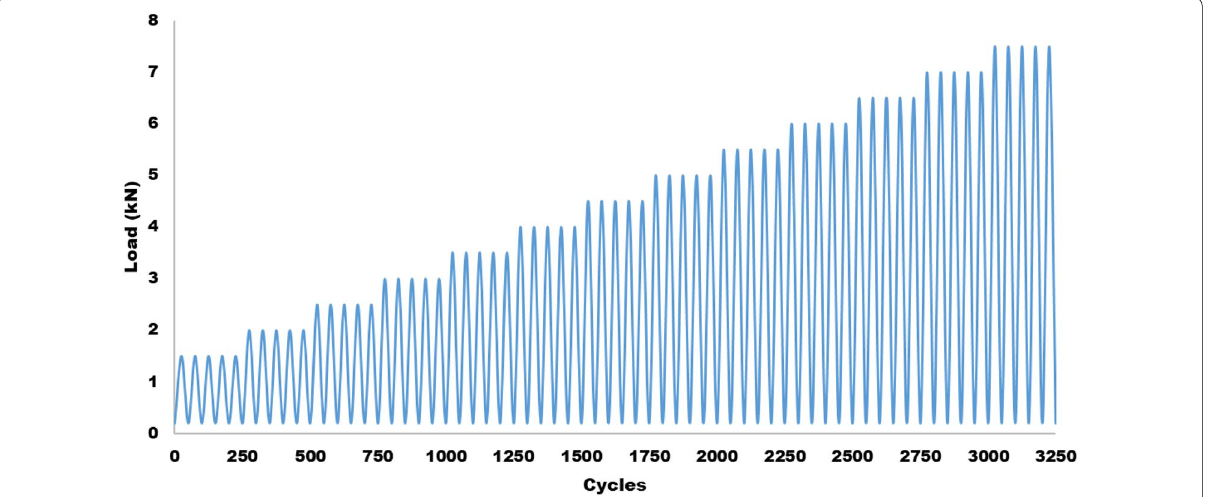
Fig. 4 Graphical representation of the loading history (load versus the number of